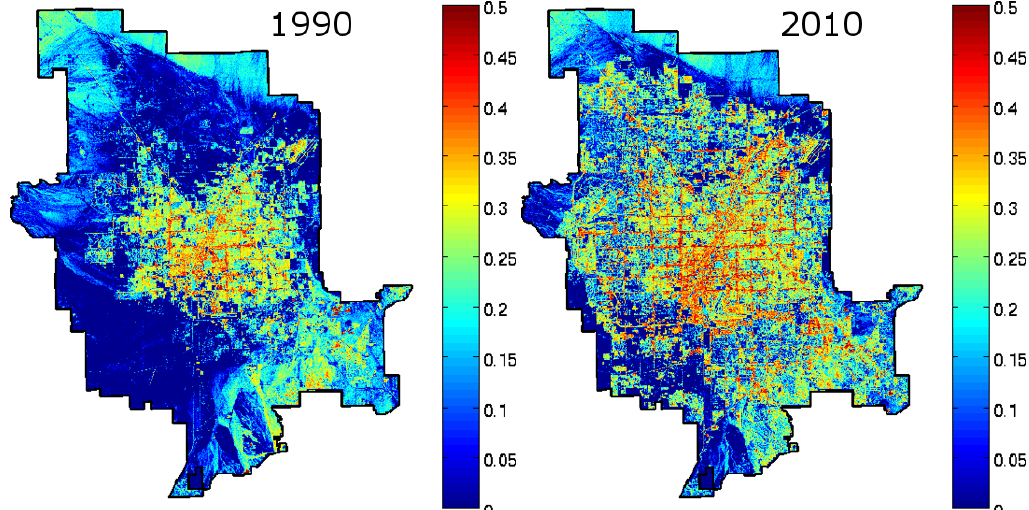
Figure 7. Change in the asphalt land cover fraction between 1990 and 2010 in Las Vegas.